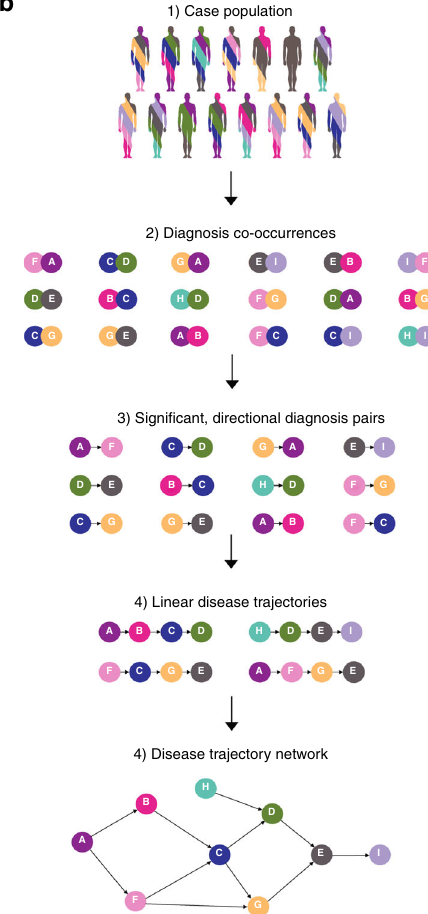
= 807,234 patients), the number of resulting linear trajectories ranges from 117 to 8359 (Table 1). These disease codes relate to a chromosomal disorder and multifactorial disease, respectively, and hence, the two cohorts have vastly different frequencies and only limited shared etiology. Consequently, the number of